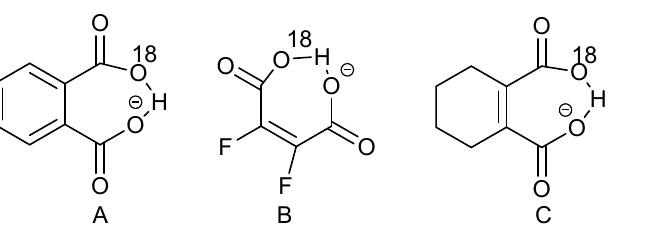
Figure 23. 18 O-labelled dicarboxylic acids. ( A ). phthalate monoanion; ( B ). difluoromaleimide; ( C ). cyclohexenedicarboxylic acid.